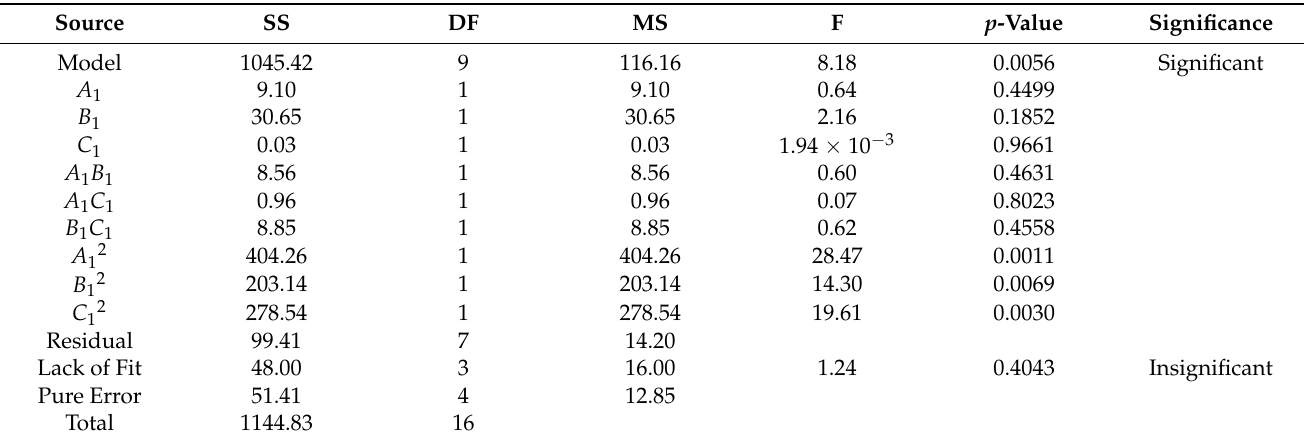
Table 3. Analysis of variance for factor model of feed